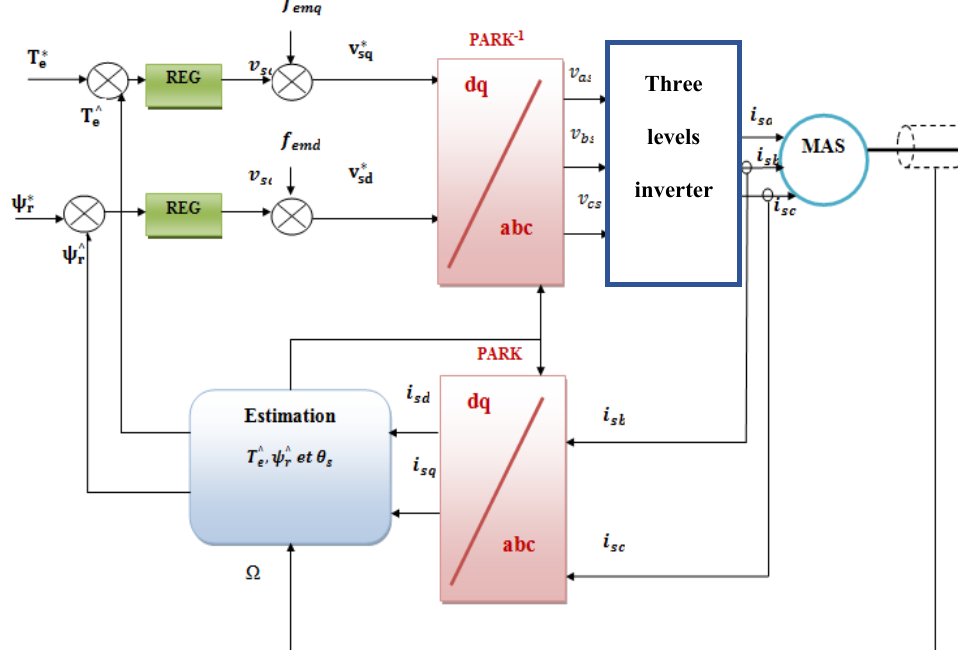
Figure 8. FOC of IM using 3L_NPC inverter.